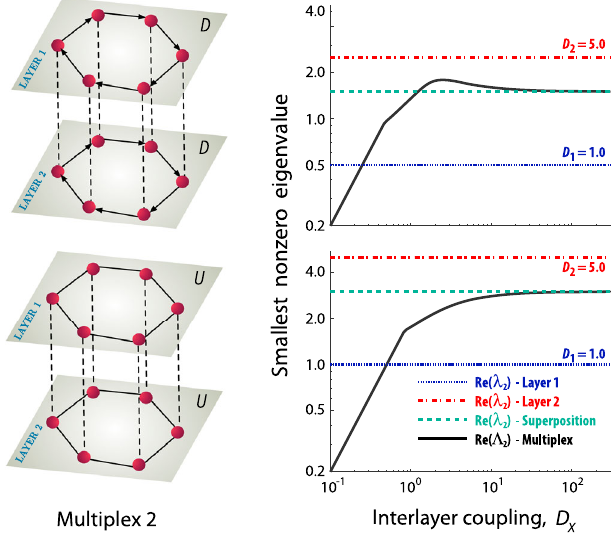
FIG. 8. Characteristic rate of convergence to stationary state solution of a continuous-time Markov chain on multiplex 1 and its undirected counterpart.